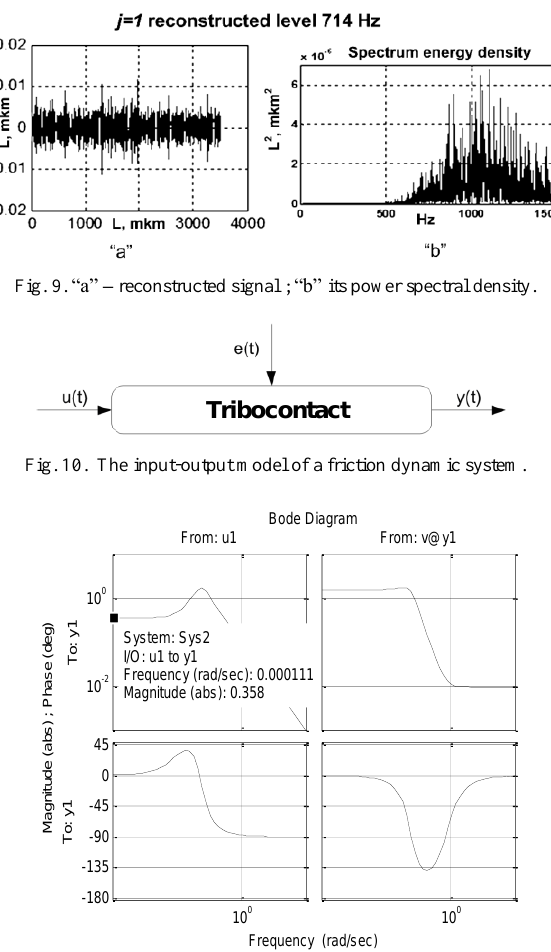
Fig. 11. Typical amplitude frequency response (Bode